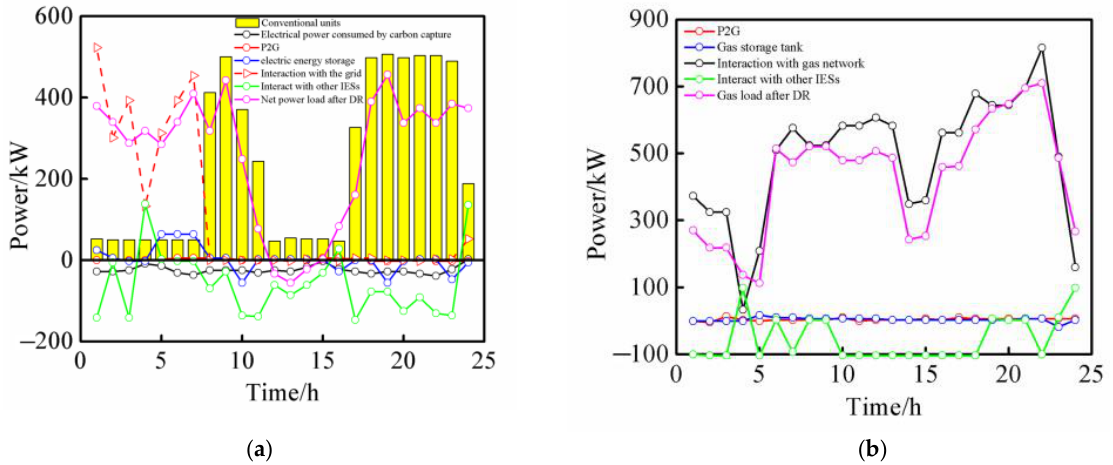
Figure 8. Balance diagram of Subsystem 2 under Scenario 4. ( a ) Electricity balance. ( b ) Gas balance.